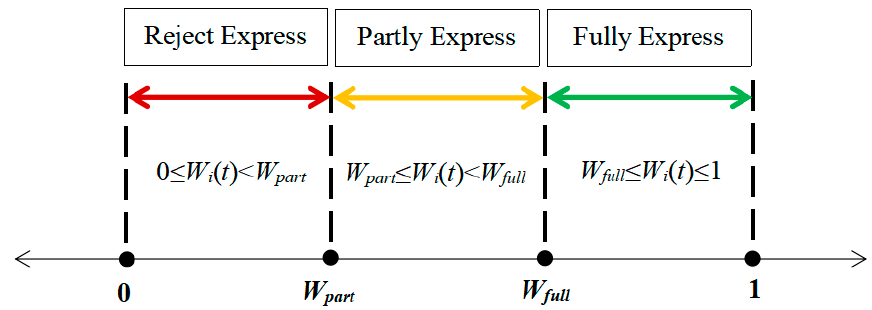
Figure 4. The expression range of individual emotion.